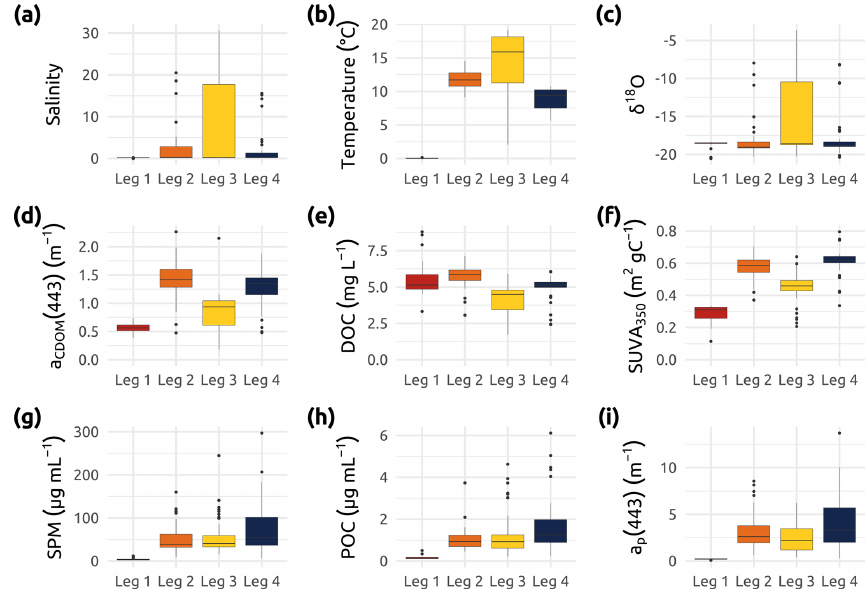
Figure 6. Box plots showing an overview of the (a) salinity, (b) water temperature, (c) δ 18 O, and a set of organic-matter-related parameters measured during the four Legs. (d) a CDOM (443) (absorption of colored dissolved organic matter measured at 443nm). (e) DOC (dissolved organic matter) and f SUVA 350 (specific ultraviolet absorbance at 350nm, i.e., a CDOM (350) / DOC) (g) SPM (suspended particulate matter). (h) POC (particulate organic carbon). (i) a p (443) (absorption of particulate matter measured at 443nm). Boxes represent the interquartile range (IQR), the horizontal lines show the medians, while the vertical lines show data spread with min/max whiskers. Note that while vertical profiles were conducted, only surface samples (from 0.3 to 1.66m) were used in these box